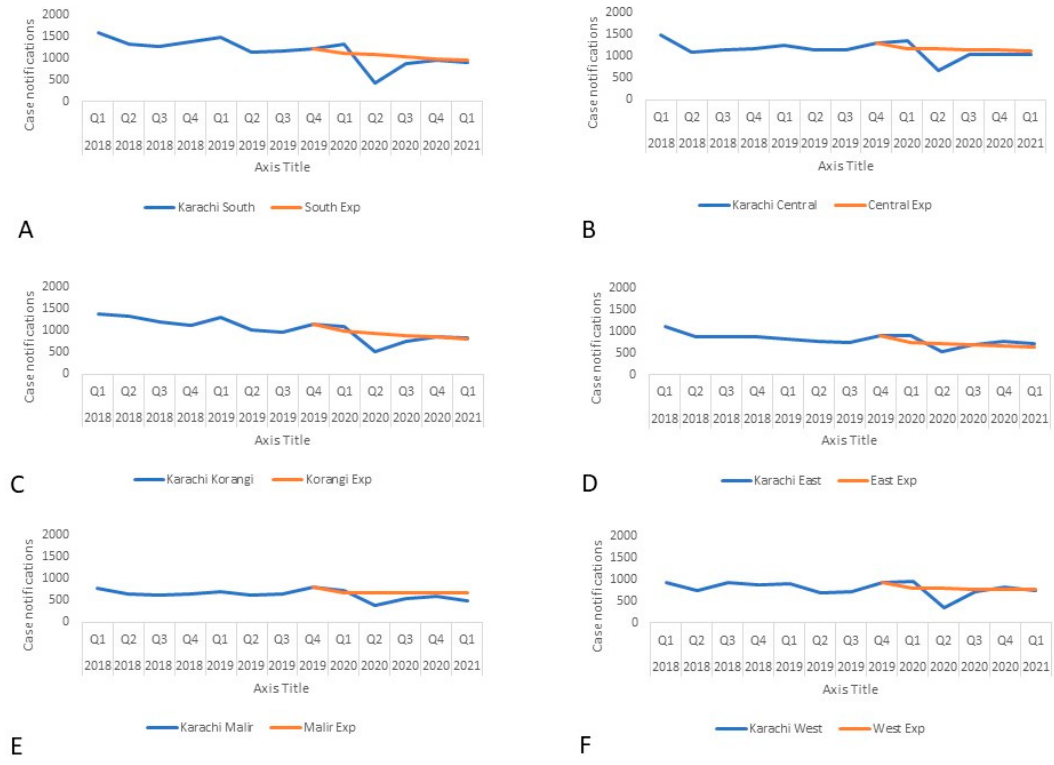
Figure 2. Actual and expected TB case notifications in Karachi by district from 2018–2021: ( A ) District South, ( B ) District Central, ( C ) District Korangi, ( D ) District East, ( E ) District Malir, ( F ) District West.